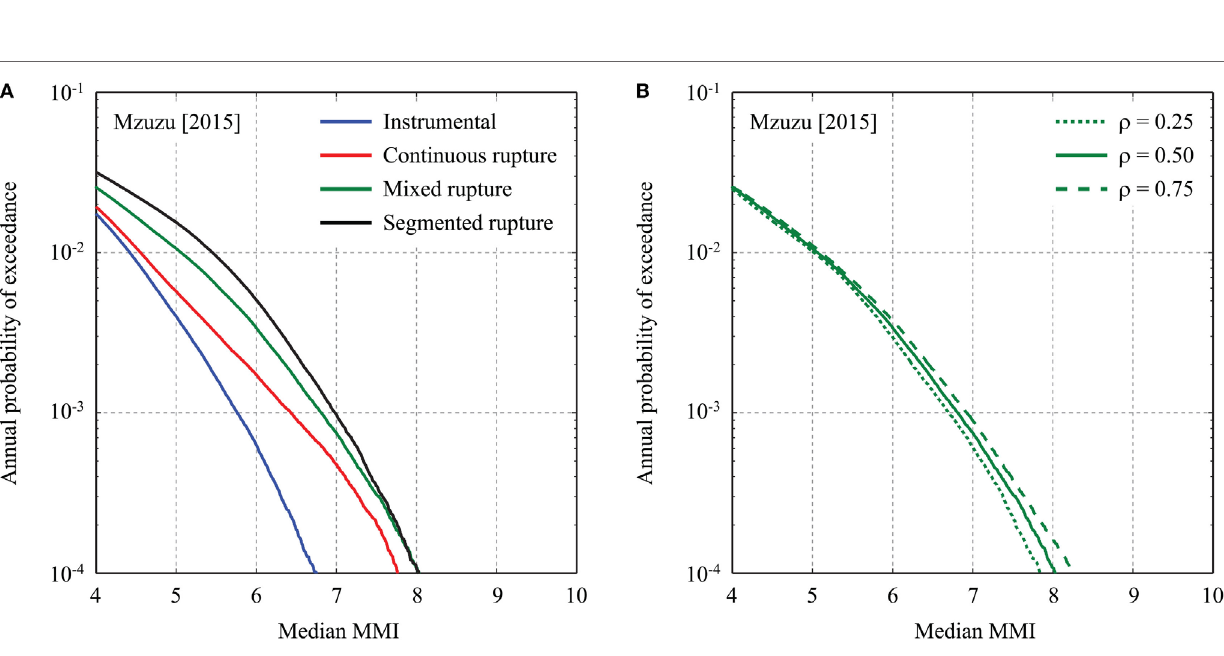
FigUre 10 | (a) Effects of different earthquake occurrence models on median MMI hazard curves for Mzuzu. (B) Effects of different MMI spatial correlation models (mixed rupture scenario) on median MMI hazard curves for Mzuzu.